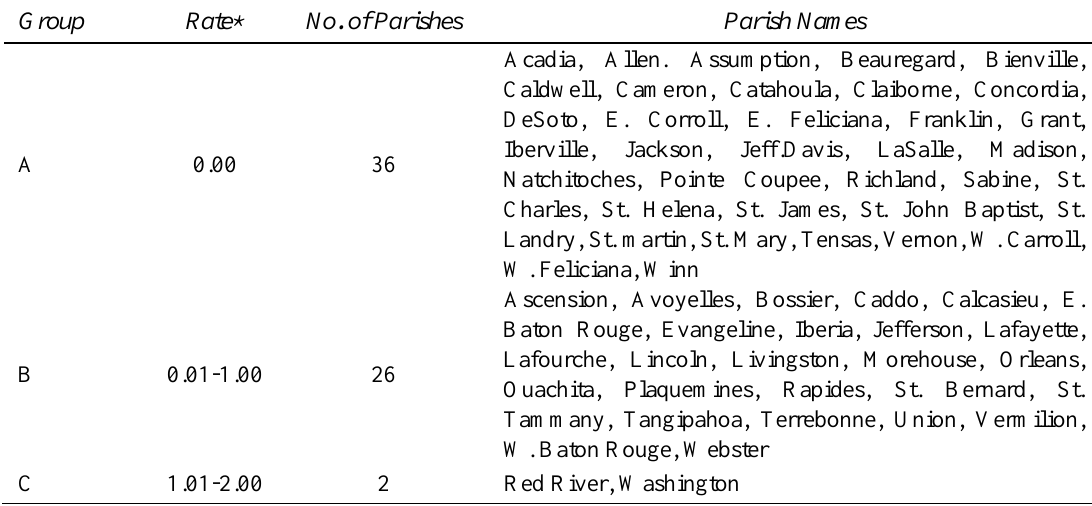
Table 6: Distribution of campylobacter in various parishes for the year 2001.